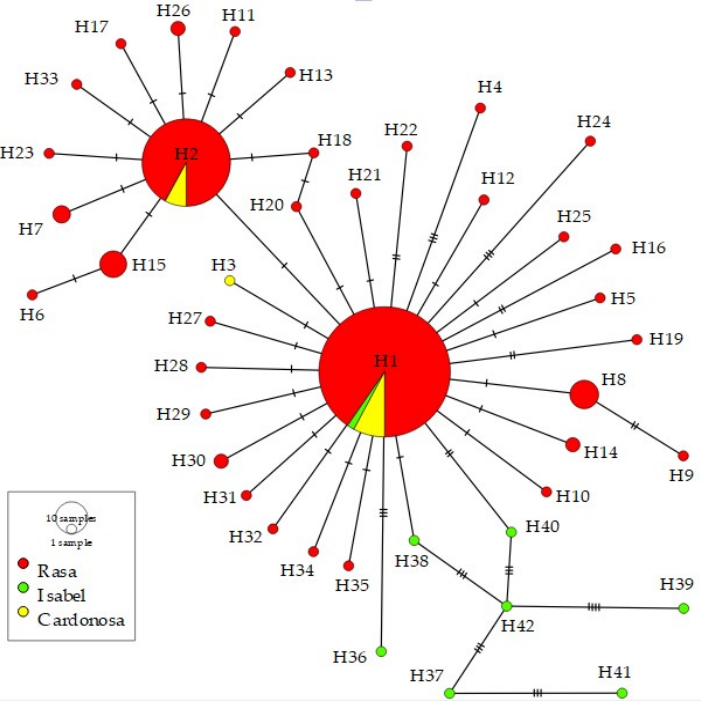
Figure 3. Minimum spanning network based on 296 mitochondrial cytochrome b sequences of Heermann’s Gull. Circle sizes are proportional to haplotype frequency. Each color indicates the island of origin: Cardonosa (red), Rasa (yellow), and Isabel (green). Haplotypes differ by one single substitution, unless additional substitutions are present (defined by small perpendicular lines). Table 4. Genetic differentiation and gene flow estimates of Heermann’s Gull at different geographic levels (regions, islands, clusters, and locations). Genetic differentiation was estimated by haplotype ( χ 2 and H ST ), and sequence-based statistics ( K ST *, Z *, and Snn ), whereas the gene flow was calculated based on haplotype data ( G ST and Nm 1 ), nucleotide data based on diversity ( N ST and Nm 2 ), and nucleotide data based on global allele frequencies ( F ST and Nm 3